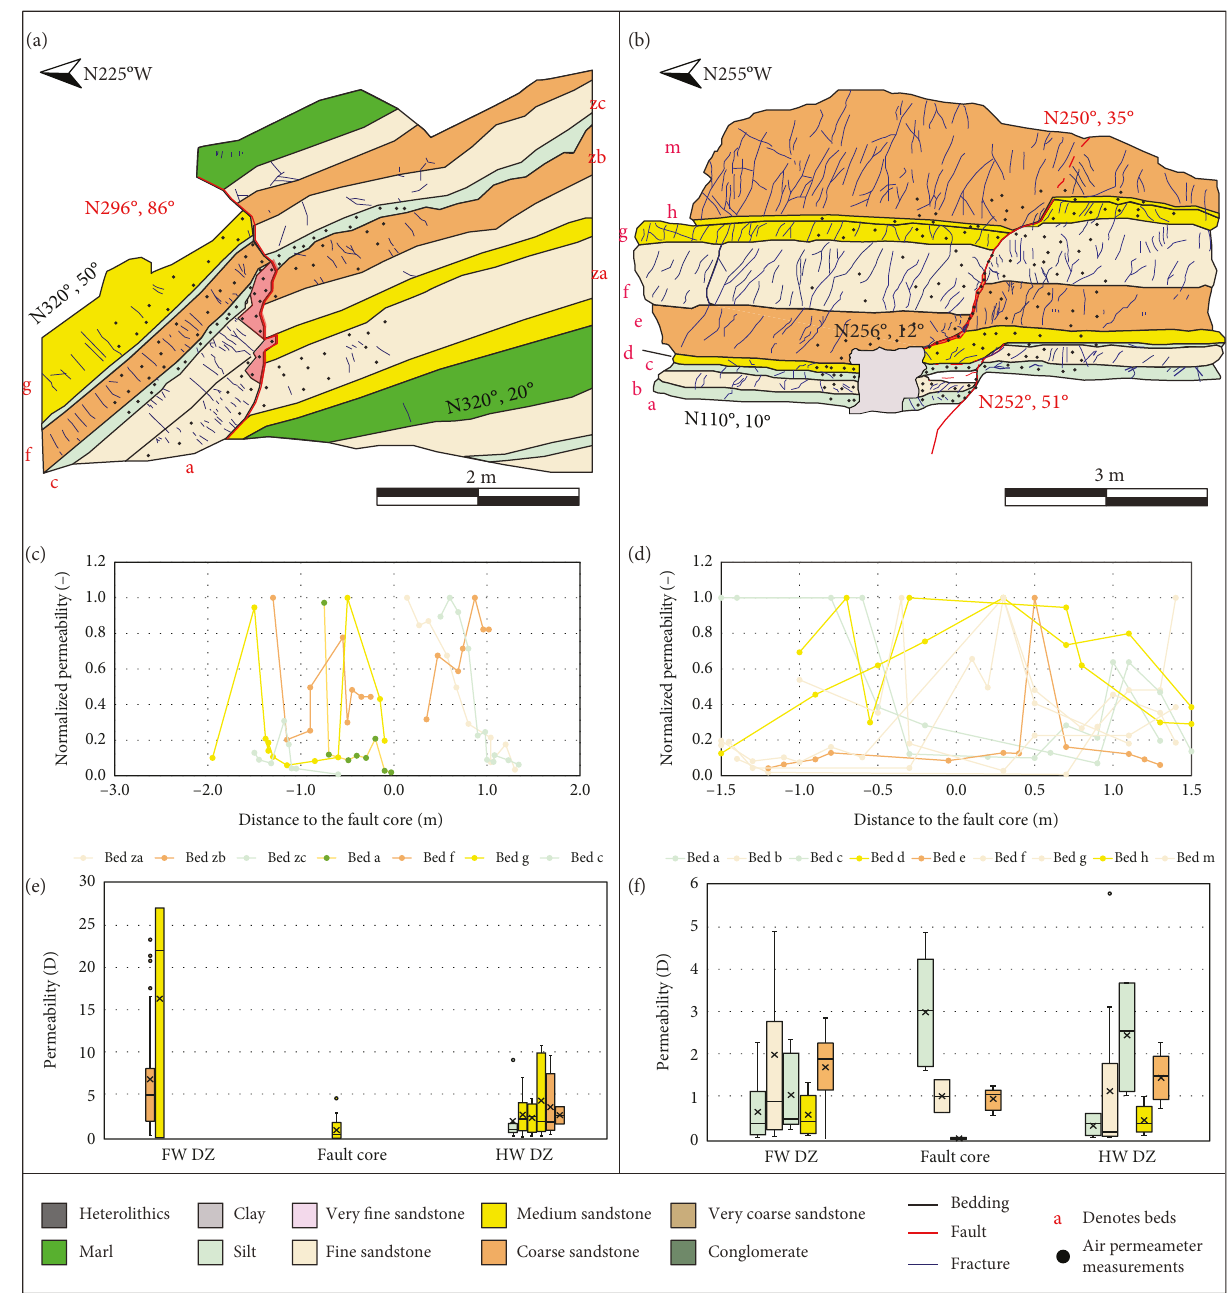
Figure 5: Permeability across well-developed faults in di ff erent styles of multilayer package. Fault orientation is denoted in right hand rule with red text, whereas bed orientation is in black text: line drawings of (a) the FWE fault, which cuts through packages of evenly distributed clay layers, and (b) the FWU fault, which cuts through packages with unevenly distributed clay layers. The grey block is representative of travertine deposit that covers the outcrop; permeability normalized for bed thickness for (c) the FWE fault and (d) the FWU fault; variation of permeability measurements shown in a box and whisker plot, in order to show the high variability across the damage zone in the hanging wall (HW DZ), the fault core, and the damage zone of the footwall (FW DZ) in (e) the FWE fault and (f) the FWU fault. Color meaning is denoted in the legend